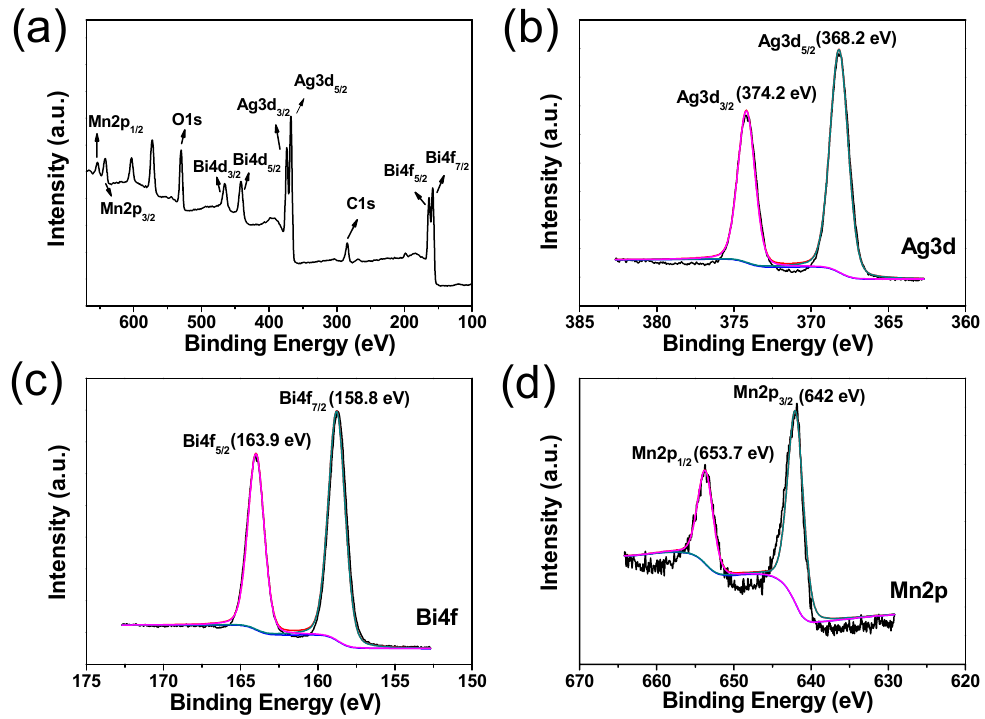
Figure 7. X-ray photoelectron spectroscopy (XPS) spectra of ( a ) Ag 4 Bi 2 O 5 with 60% Mn, ( b ) XPS spectra of Ag 3d, ( c ) XPS spectra of Bi 4f, ( d ) XPS spectra of Mn 2p.